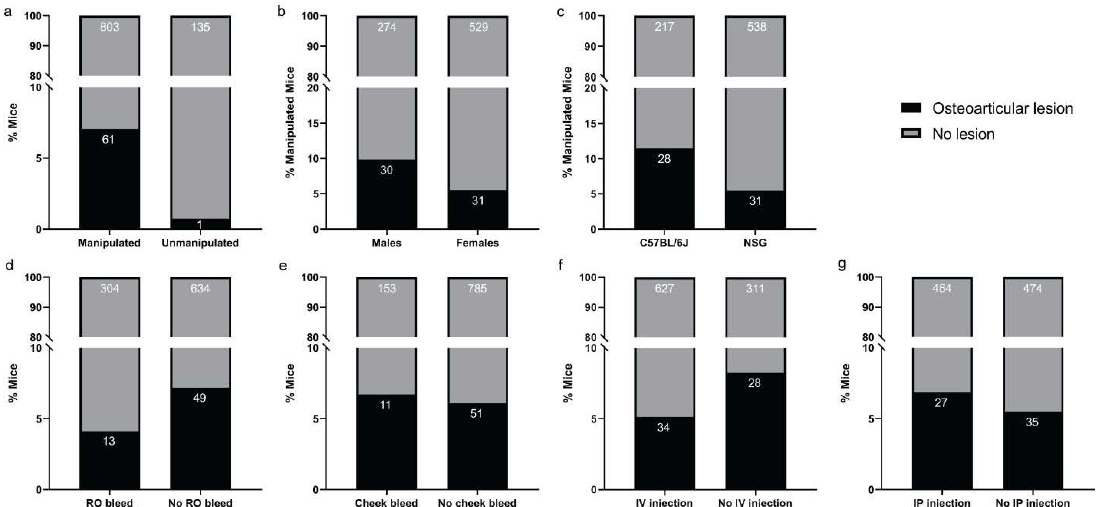
Figure 3. Statistical comparisons of the frequency of traumatic osteoarticular lesions. Statistical comparisons of the frequency of traumatic osteoarticular lesion between: ( a ) manipulated and unmanipulated mice ( p = 0.0018 **), ( b ) male and female manipulated mice ( p = 0.0253 *), ( c ) NSG and C57BL/6J manipulated mice ( p = 0.0046 **), ( d ) mice undergoing retro-orbital bleeding or not ( p = 0.0671 ns), ( e ) mice undergoing cheek bleeding or not ( p = 0.7250 ns), ( f ) mice undergoing tail vein injections or not ( p = 0.0708 ns), and ( g ) mice undergoing intraperitoneal injection(s) or not ( p = 0.4316 ns). ns p > 0.05; * p ≤ 0.05; ** p ≤ 0.01 by Fisher’s exact test. RO, retro-orbital;